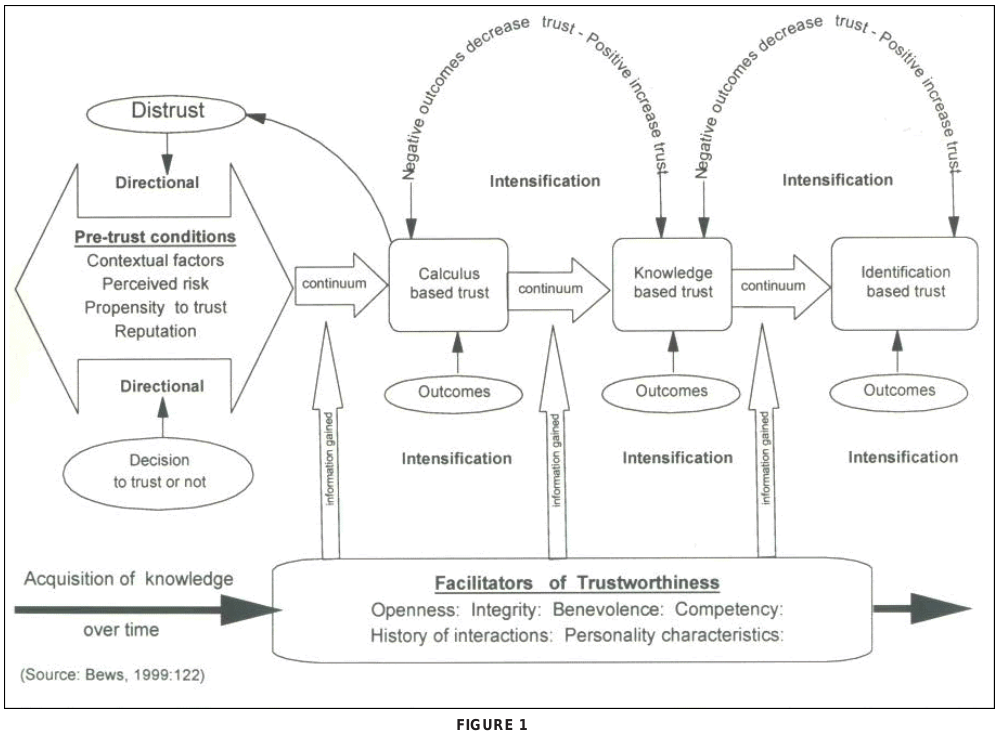
Figure 1 Development of organisational trust (Source: Bews, 1999, p.